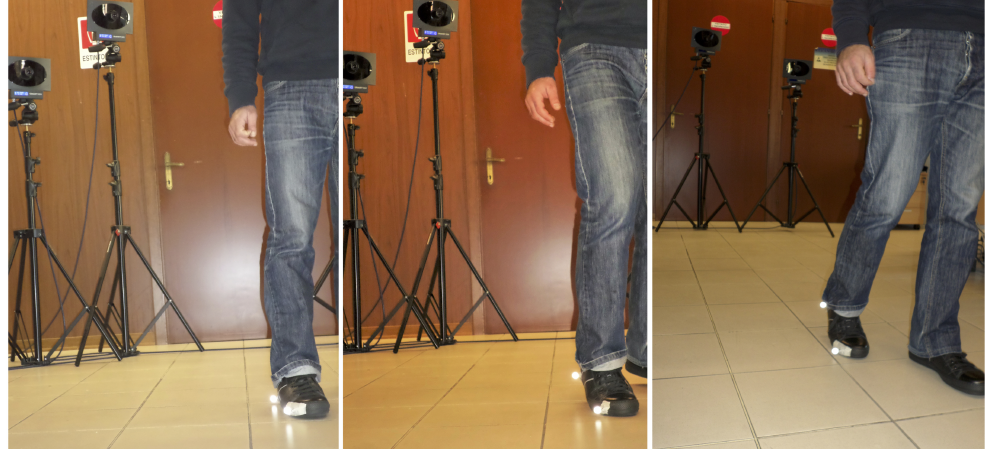
Figure 3. Subject performing the trials within the motion capture (BTS system) workspace. The two markers, attached to the right FootMoov shoe at the tip and heel area, are tracked by the BTS system during the walking